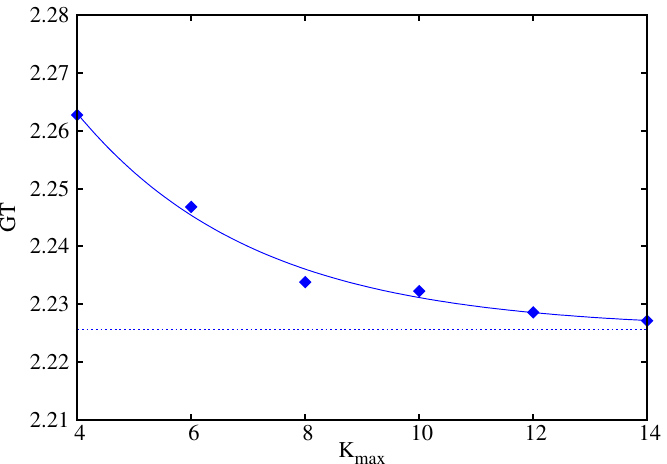
Fig. 7. The convergence of the GT matrix element for the 6 He- 6 Li β -decay. The continuous line is the fit GT(K max ) = GT ∞ + Be − β K max , the dashed line is the extrapolated value GT ∞ . Figure taken from